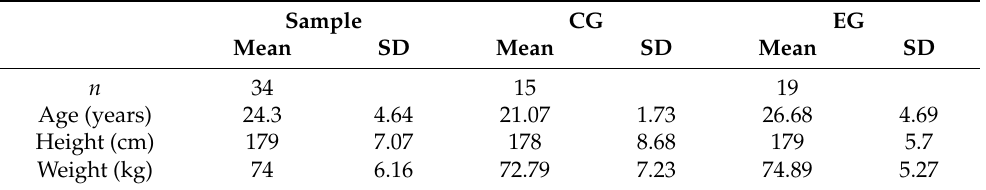
Table 1. Baseline characteristics.